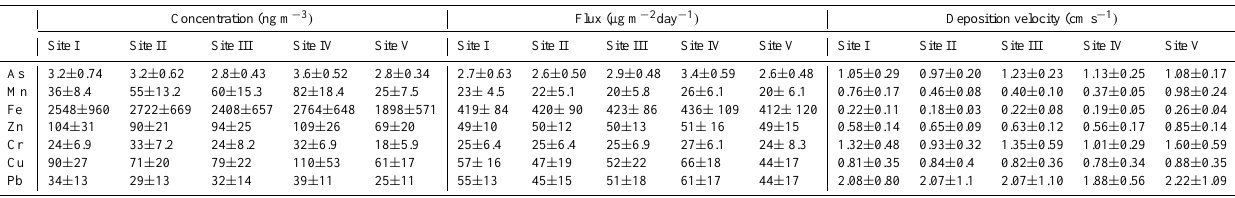
Table 1. Annual average ( ± standard deviation) of the measured concentration (ngm − 3 ) , the dry deposition (µgm − 2 day − 1 ) and the dry deposition velocity (cms − 1 ) for seven metal species (As, Mn, Fe, Zn, Cr, Cu and Pb) in total suspended particulates at five sites